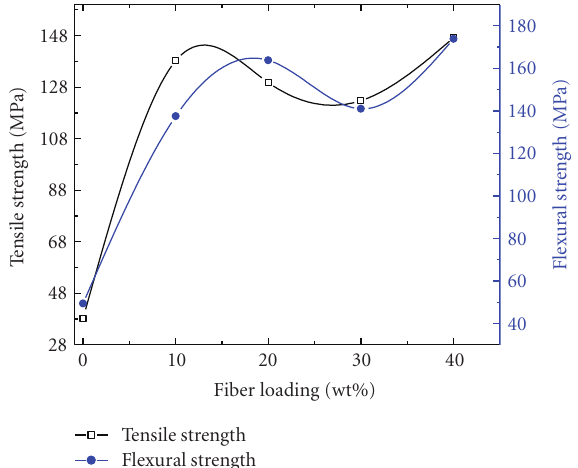
Figure 4: E ff ect of fiber loading on strength of composites. Figure 5: E